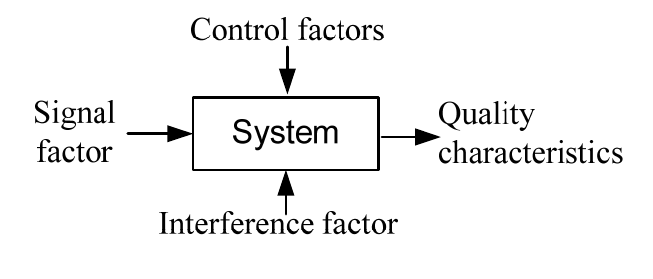
Table 1. Level of control factor